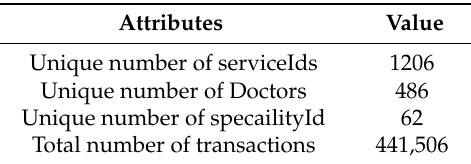
Table 2. Attributes in